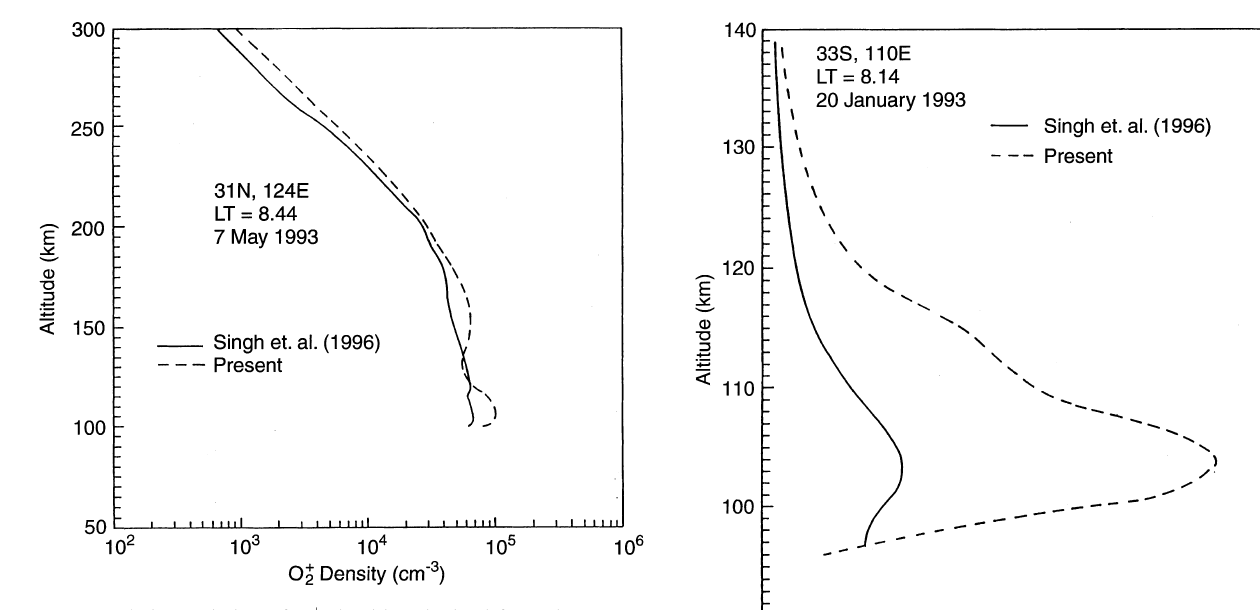
densities obtained from the present 2